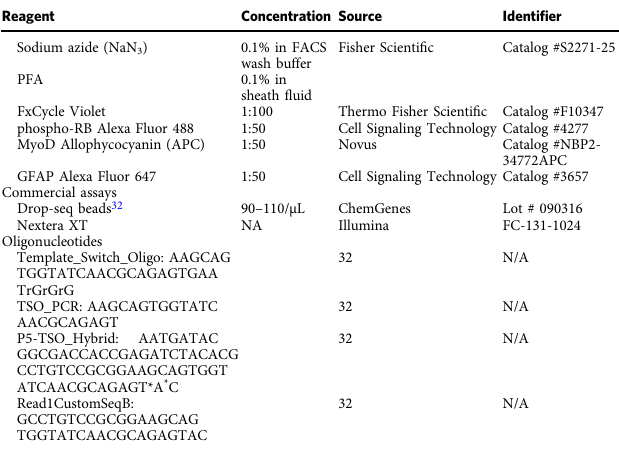
NMP:PEG (1:10) once daily from P12 to P14 and then every other day and col- lected at P25. Mice were monitored daily for changes in body weight and symp- toms such as ataxia, tremor and seizures. Animals were euthanized and brains collected if body weight dropped more than 20% over 24h and/or they developed severe neurological symptoms according to approved protocols. Tissue preparation for Drop-Seq and fl ow cytometry . Mice were anesthetized with iso fl urane and euthanized by decapitation. Brains were cut in half sagittally and drop- fi xed in 4% paraformaldehyde for IHC, and half cerebellum or tumor collected for Drop-Seq. Alternatively, half of the tumor was collected for fl ow